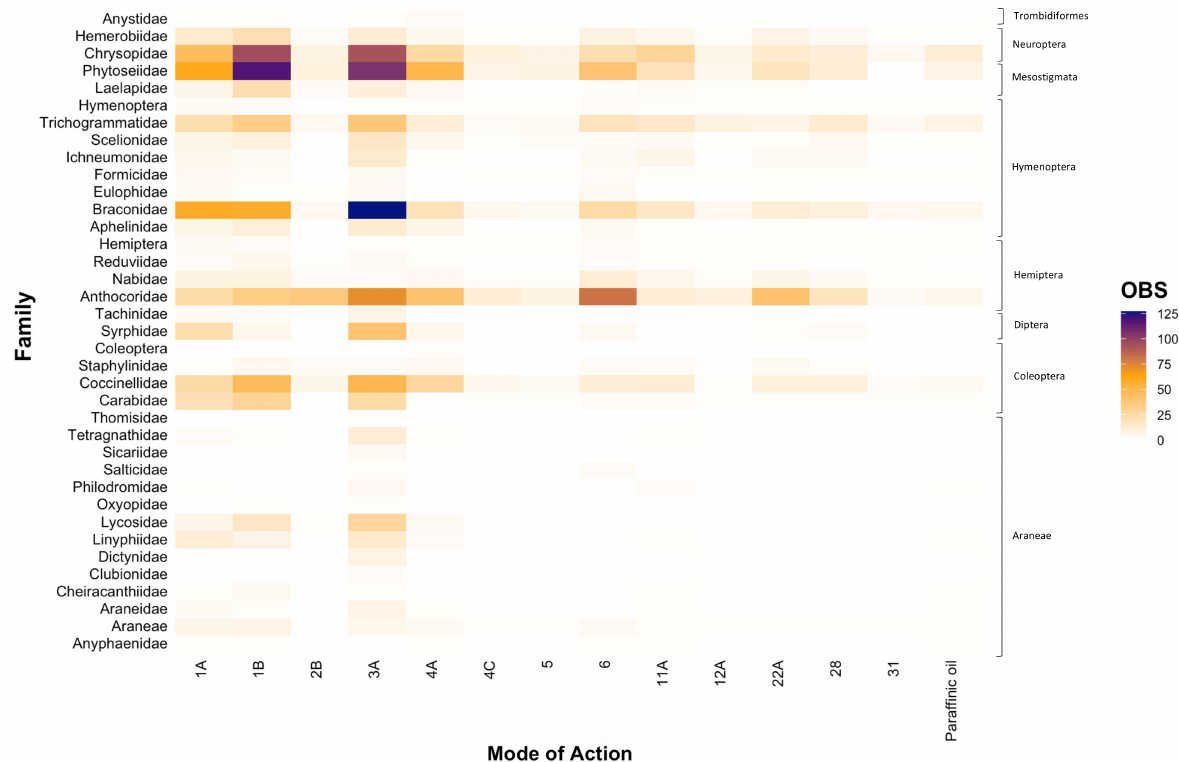
Figure 2. The number of entries (OBS) that tested the toxicity of chemical Modes of Action for each natural enemy family relevant to the Australian grains industry. Note: Araneae, Coleoptera, Hemiptera, and Hymenoptera are included as they were the lowest taxonomic classification provided in some